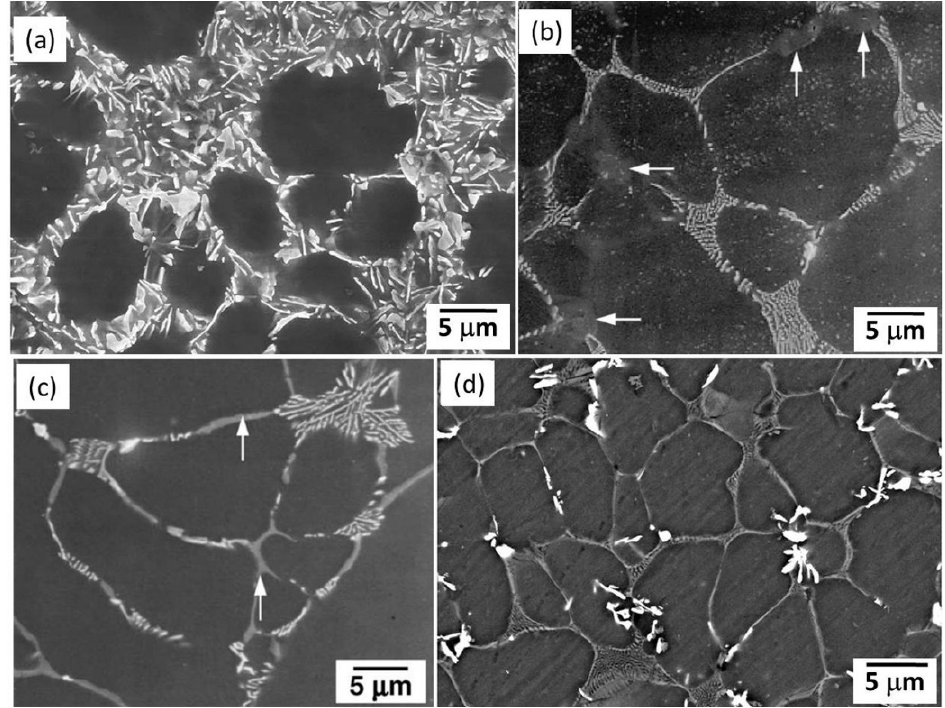
Figure 4. SEM images of the HPDC ( a ) ALa44 + 0.5Sr [80]; ( b ) AE42 + 0.5Sr [102]: ( c ) AE42 + 1.0 Sr [102]; ( d ) AE42 + 2.0Ca [68] alloys.